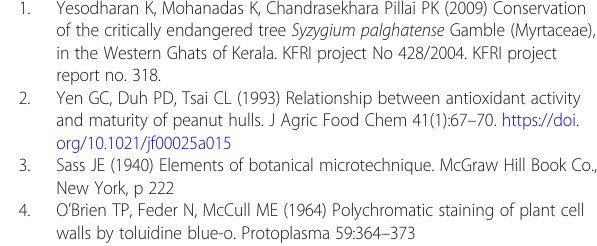
Table 8 Alpha glucosidase inhibitory assay of S . palghatense leaves and bark Concentration ( μ g/ μ l)